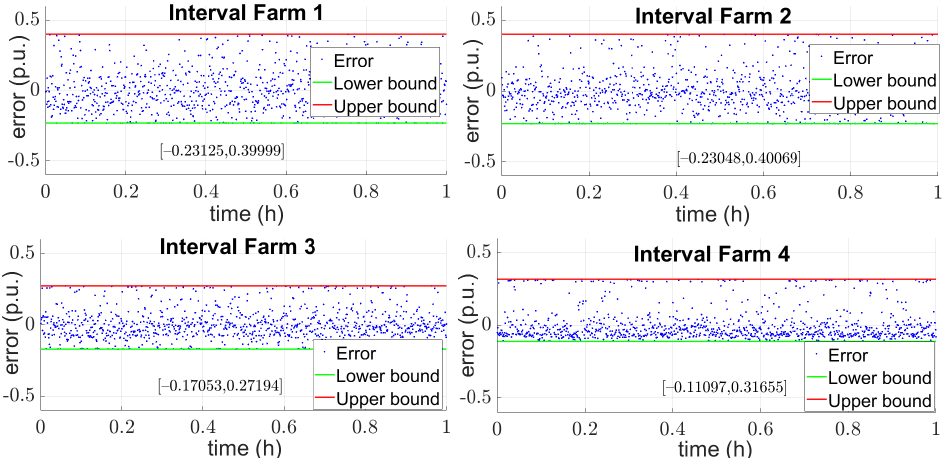
Figure 4. The first hour measured power error